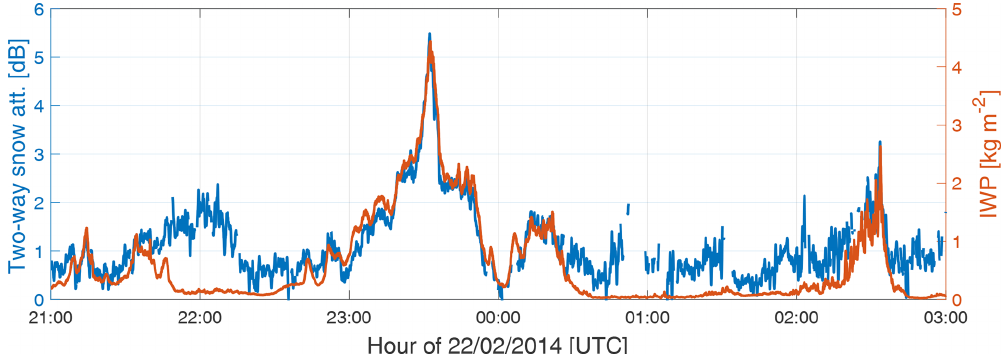
Figure 12. Two-way snow attenuation (scale on the left y axis) against IWP (scale on the right y axis) as function of time in UTC. Snow attenuation was derived from the difference between observed (cid:49) PIA and calculated liquid water attenuation based on LWP retrieved by the MWR. IWP was derived with the IWC–Z K relation proposed by Protat et al. a